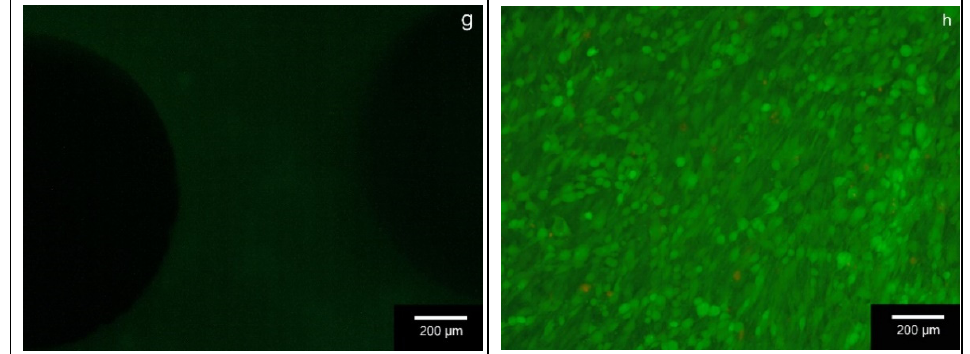
Figure 13. Living/dead cells on the inner surface of the ceramic; 500 μ m scaffold after three days (( a ): Hybrid foam; ( b ): Curasan), seven days (( c ): Hybrid foam; ( d ): Curasan) and 10 days (( e ): Hybrid foam; ( f ): Curasan); ( g ) : Auto-fluorescence of the ceramics; ( h ) : Thermanox membrane (pos. control, 10 days); white bar = 200 μ m. Green indicates living cells; red indicates dead cells. Quantitative results of the number of living and dead cells per mm 2 is shown in Figure 14a,b, respectively. The number of living cells increased over the course of the experiment in both the scaffold and the Curasan control, with no significant differences between our scaffold and the Curasan control.